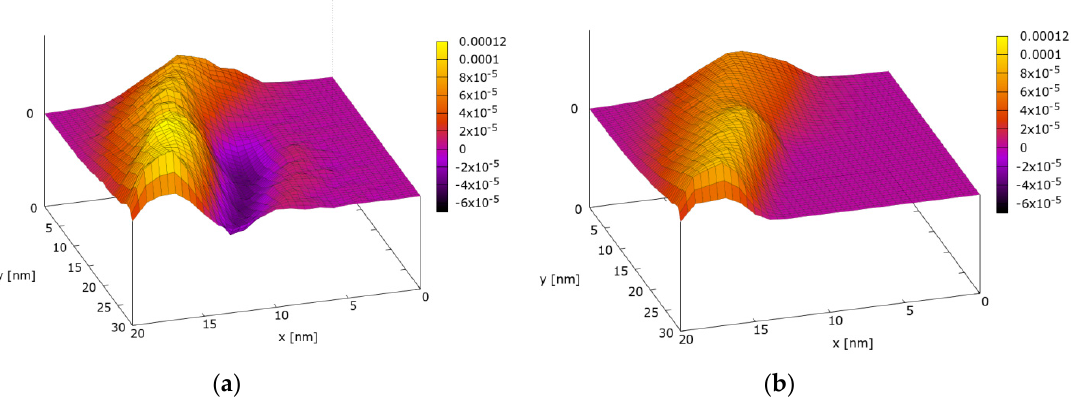
Figure 5. Comparison between quantum and classical phase-space distribution in the point ( k x2, k y2 ) = (0.26 nm − 1 , 0.89 nm − 1 ): ( a ) quantum Wigner distribution, ( b ) classical Boltzmann distribution.